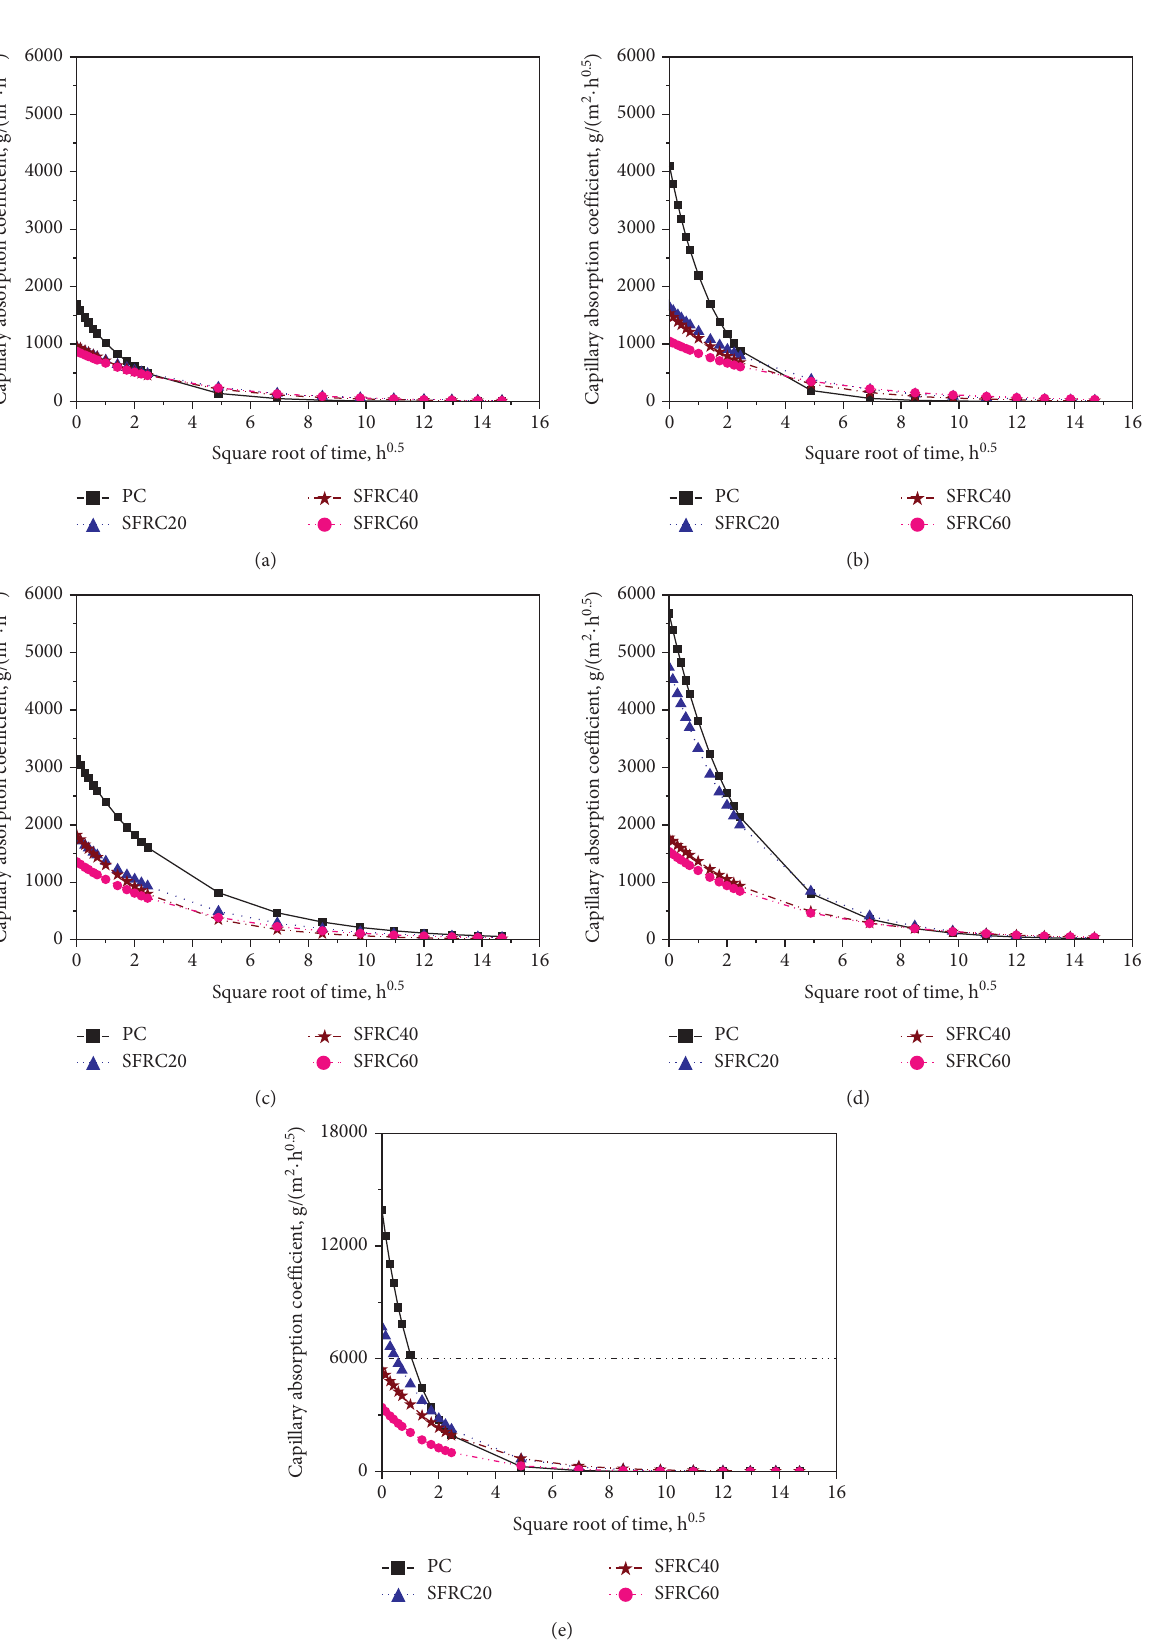
Figure 7: Comparison of the coefficient of CWA of the samples after different FTCs: (a) 0; (b) 25; (c) 50; (d) 75; (e)